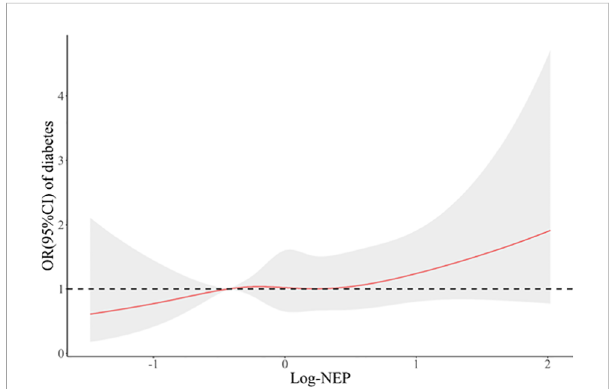
FIGURE 3 A restricted cubic spline curve illustrating the association between serum neprilysin and prevalent diabetes at baseline. Legend: A restricted cubic spline regression model was constructed with knots set at the 10 th , 50 th , and 90 th percentiles of the distribution of serum NEP. The red line indicates the odds ratios and the gray shadow indicates the corresponding 95% con fi dence intervals of prevalent diabetes in association with the increasing levels of log-NEP, compared with the midpoint of the 10 th percentile. Serum NEP was linearly ( P for non-linearity=0.853) associated with a higher risk of prevalent diabetes (OR=1.28, P =0.072). OR, odds ratio; CI, con fi dence interval.